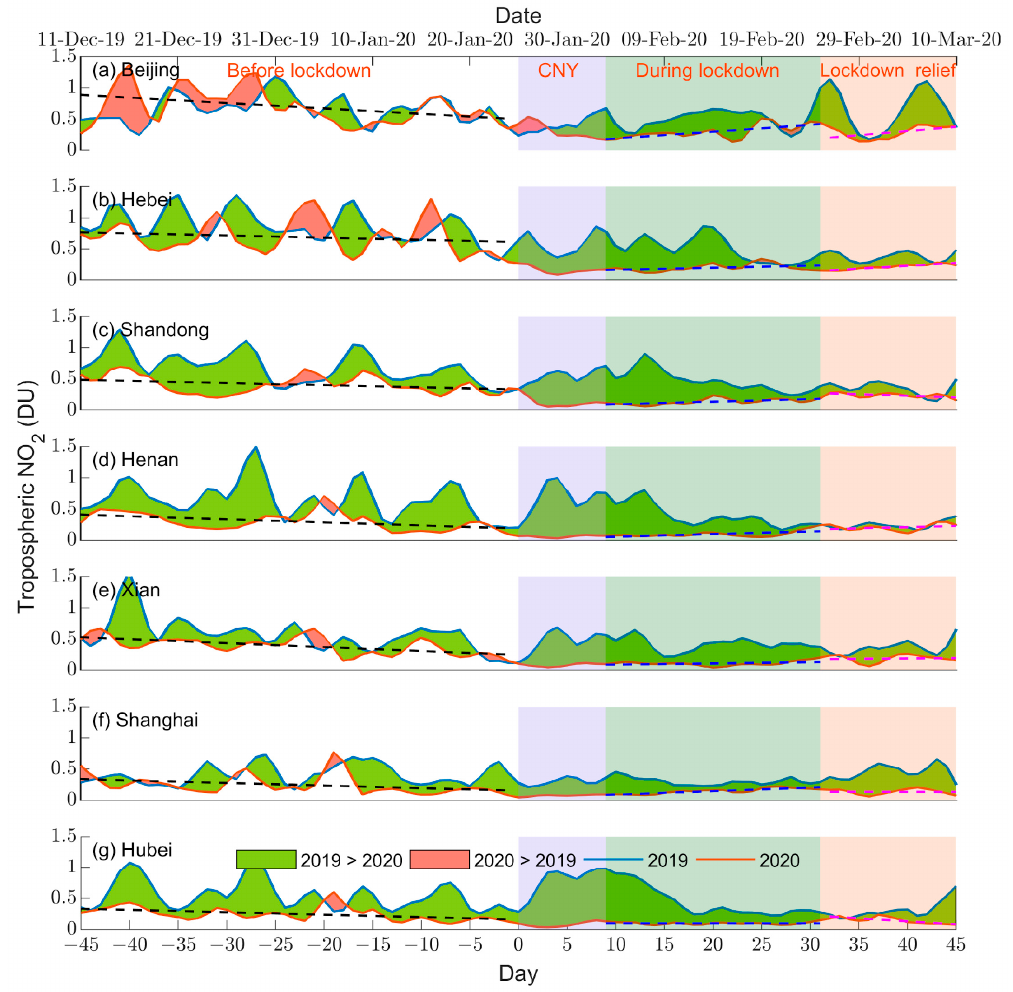
Figure 3. Time series of daily NO 2 concentrations across seven study regions of China, comparing equivalent periods in 2019 and 2020. The times when NO 2 concentrations were higher in 2019 than in 2020 are shaded in yellow-green, while the times when the concentrations were higher in 2020 than in 2019 are shaded in salmon. Trends are also plotted for the three separate periods of before lockdown, during lockdown, and after lockdown for 2020.